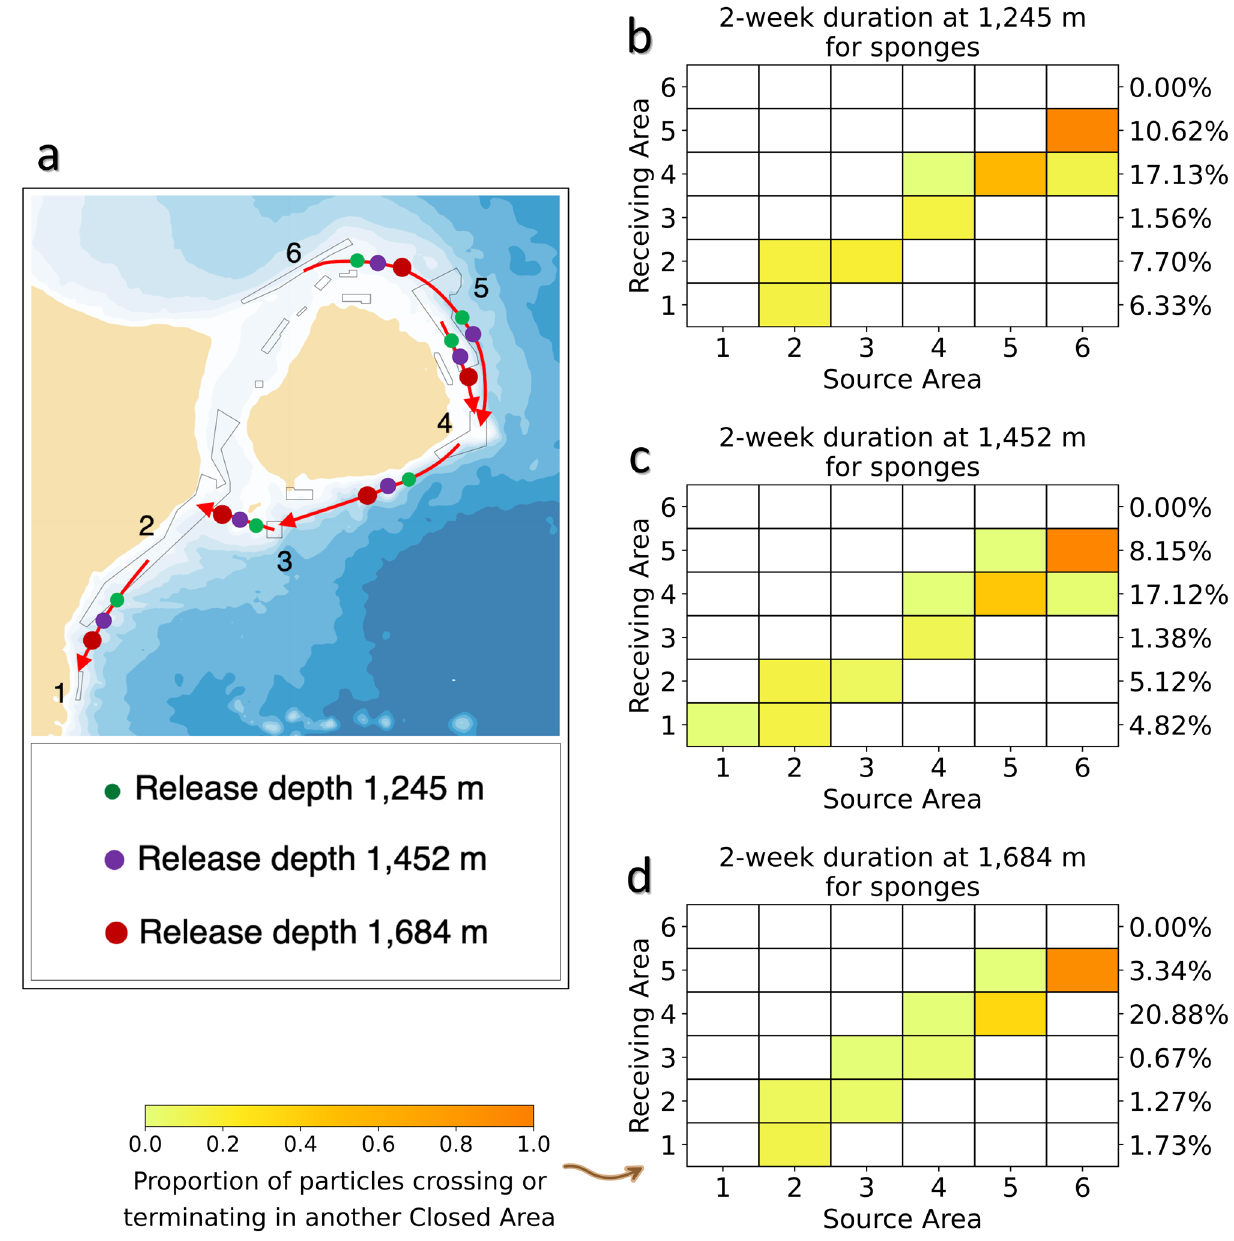
Figure 5. Functional connectivity among areas closed to protect sponges. ( a ) Forward-tracking connectivity pathways for particles released at 3 depths in each of the 6 areas closed to protect large-size sponges (Areas 1–6) showing chain-linking and minimal redundancy in Area 4. Drift durations were 2 weeks. The closed circles over the lines indicate particles can reach another area when released from this depth. The map was generated using bathymetry and coastline data produced and made publically available by the NOAA National Centers for Environmental Information (NCEI). The ETOPO1 Ice Surface (https:// doi. org/ 10. 7289/ V5C82 76M) arc- minute global relief model of the Earth’s surface (https:// www. ngdc. noaa. gov/ mgg/ global/) was used to generate bathymetry and the Global Self-consistent, Hierarchical, High-resolution Geography Database (GSHHG; https:// www. ngdc. noaa. gov/ mgg/ shore lines/ gshhs. html) was used to produce co-ordinates for a high-resolution coastline and both plotted using Matlab version 9.5 software (https:// www. mathw orks. com) with the M_Map mapping package (version 1.4 m, created by R. Pawlowicz, https:// www. eoas. ubc. ca/ ~rich/ map. html); ( b – d ) the proportion of modeled particles released from each of the 6 areas closed to protect large-sized sponges (Source Areas; Areas 1, 2, 3, 4, 5, 6) and passing over or terminating in another area closed to protect large-size sponges (Receiving Areas). For each Receiving Area the percentage of the total number of particles released (from all source areas) are provided. Those values include particles that crossed, terminated or were retained in the Receiving Area. Drift durations were 2 weeks using average currents from the ocean model. Release depths were 1245 m, 1422 m and 1684 m